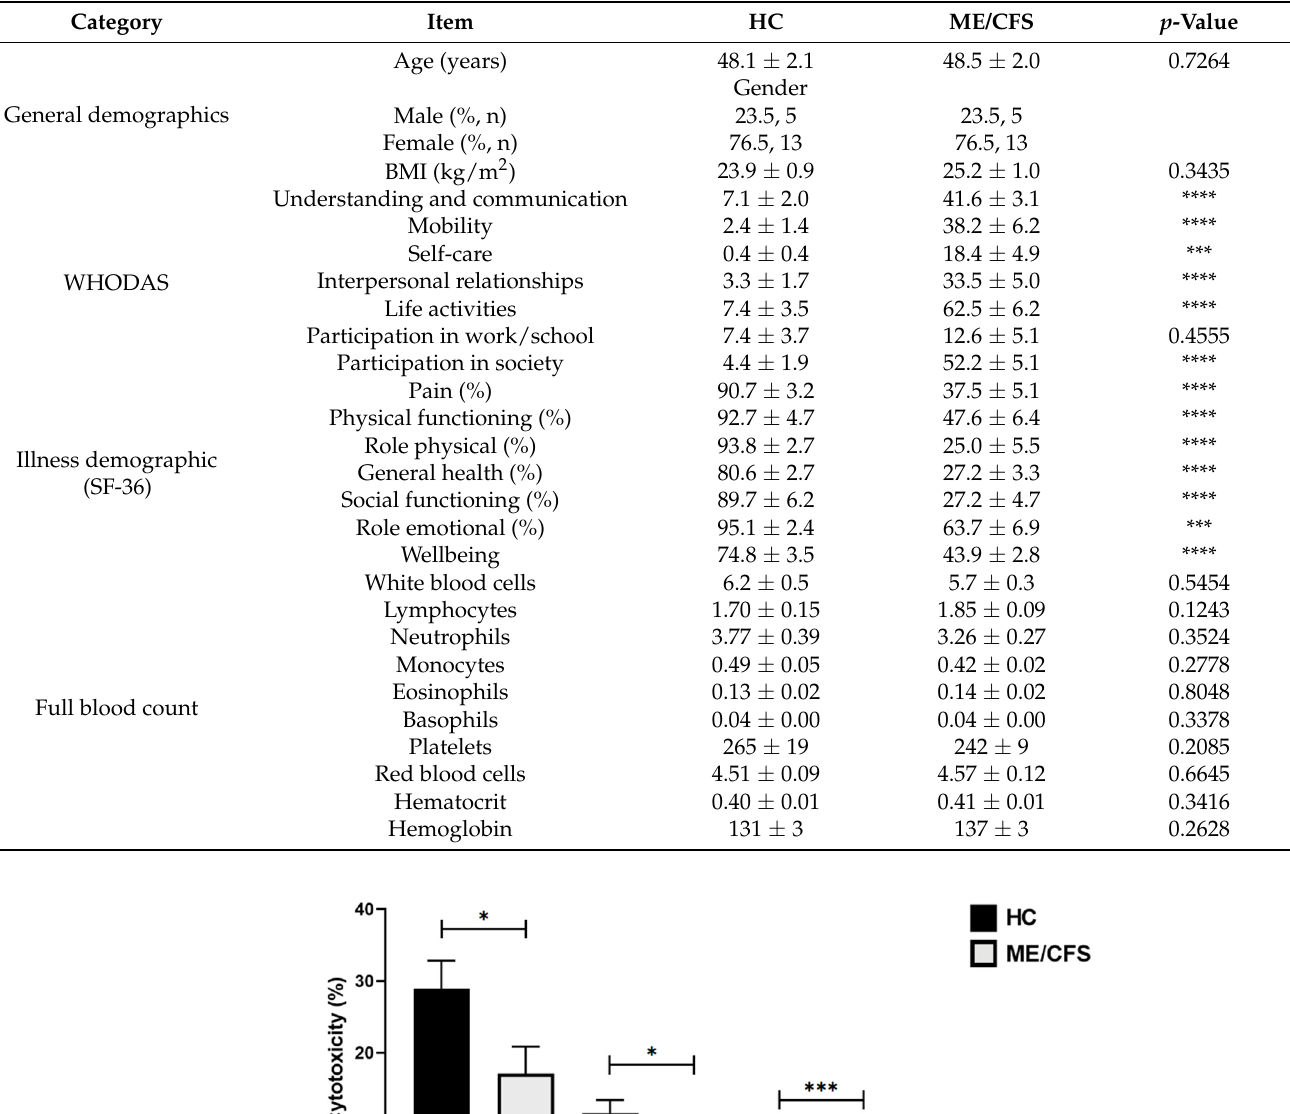
Table 1. Participant demographic and full blood count results; n = 17 for HC and n = 17 for ME/CFS. Data are represented as mean ± SEM using Mann-Whitney U tests. *** p < 0.001, **** p < 0.0001. Abbreviations: healthy control (HC), myalgic encephalomyelitis (ME/CFS), body mass index (BMI), World Health Organization disability assessment schedule (WHODAS), short-form health survey (SF-36).